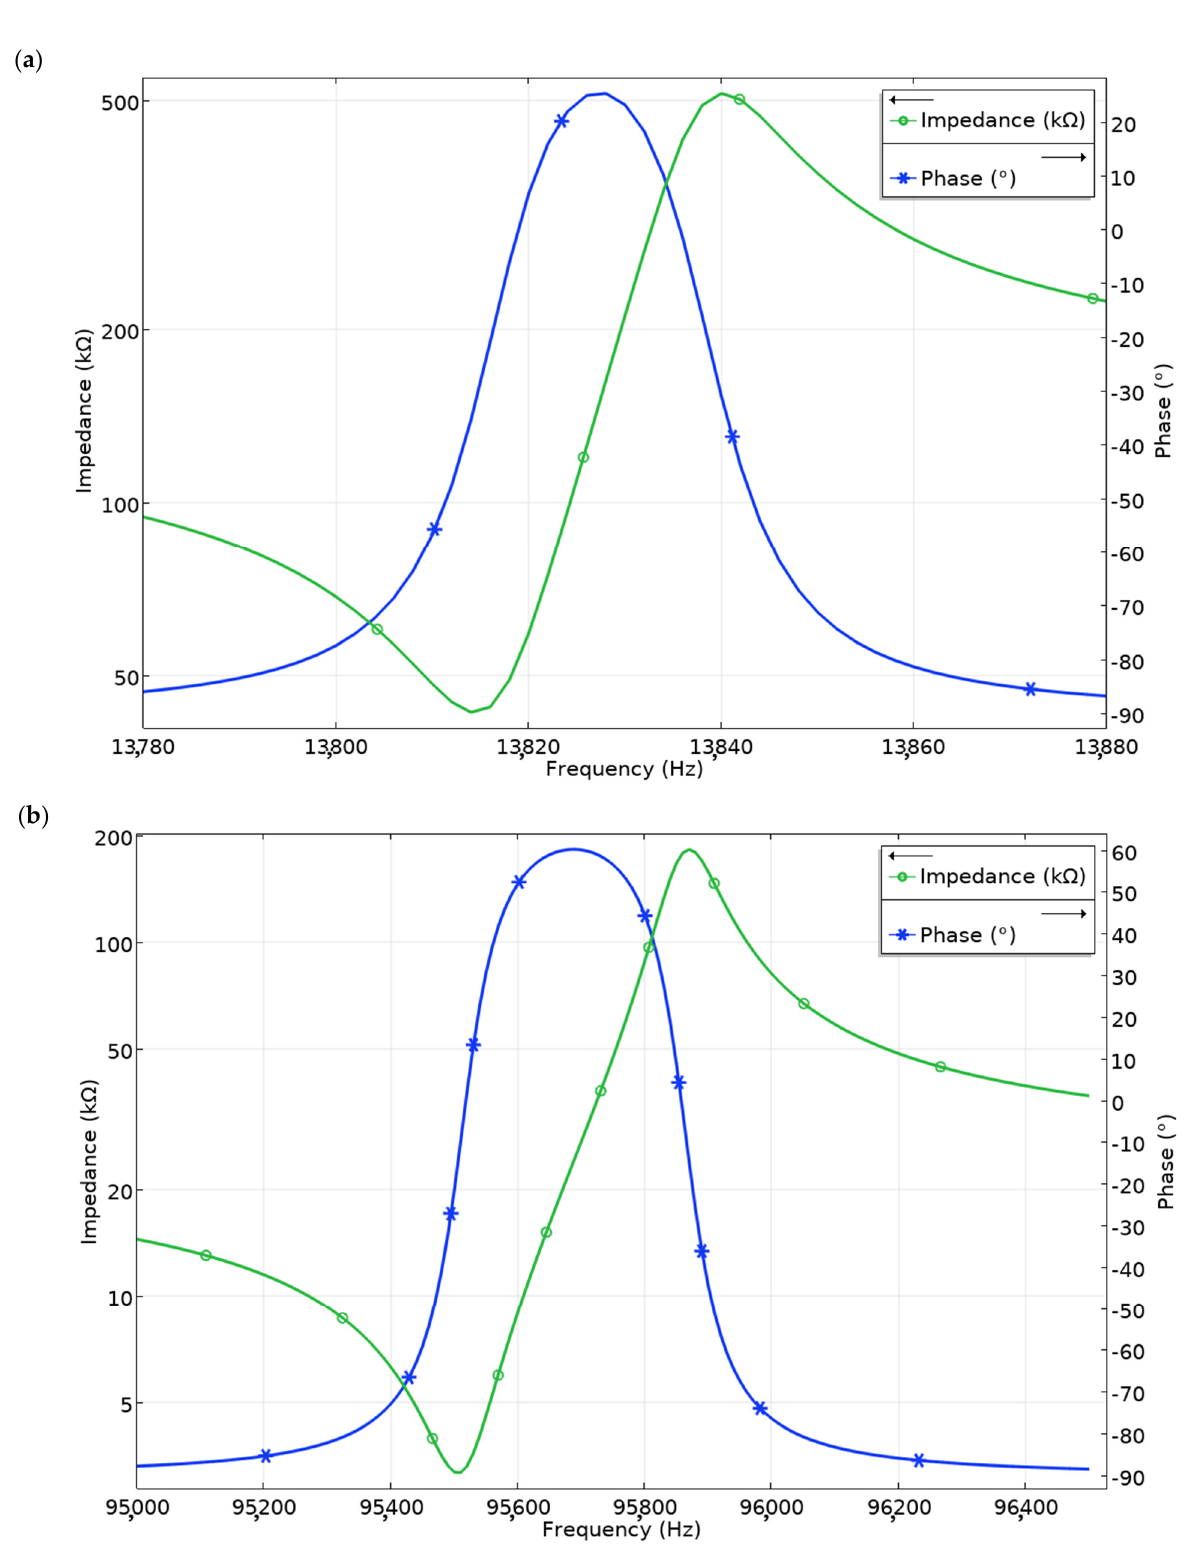
Figure 5. Impedance and phase-frequency characteristics of the piezoelectric robot in a frequency range of ( a ) 13.78–13.88 kHz and ( b ) 95.0–96.50 kHz. range of ( a ) 13.78–13.88 kHz and ( b ) 95.0–96.50